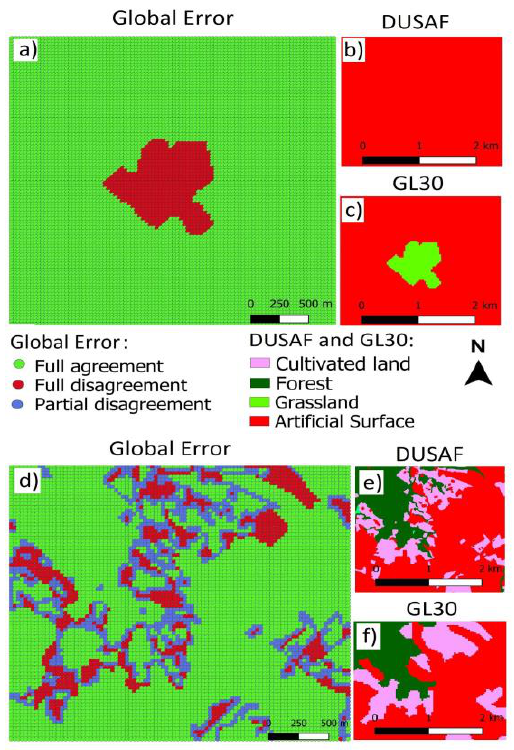
Figure 4. Example of visual exploration experiment on error